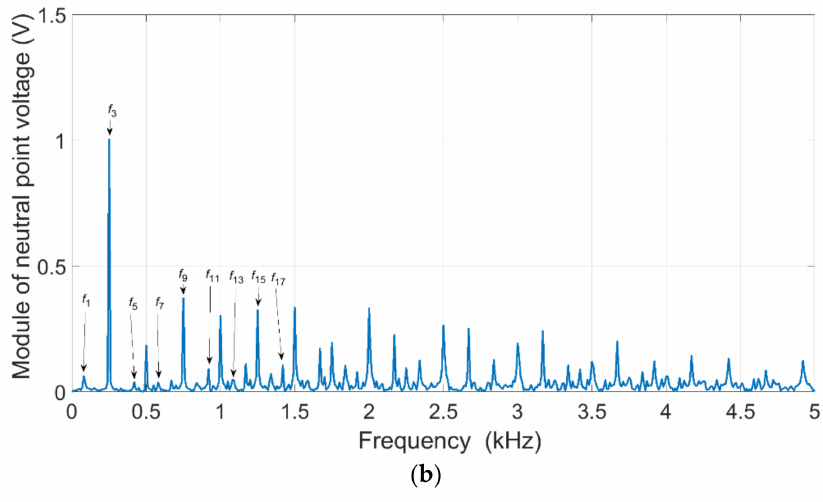
Figure 7. Y configurations—FFT of neutral voltage—healthy: ( a ) numerical calculations, ( b ) measurement.